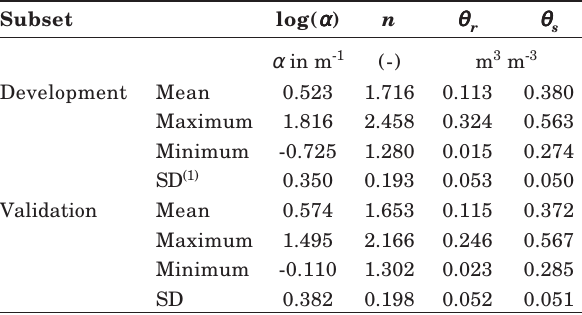
Table 3. Descriptive statistics for estimates of equation 2 parameters a , n , q r and q s of the fitted original van Genuchten model for the PTF development ( N = 673) and validation subsets